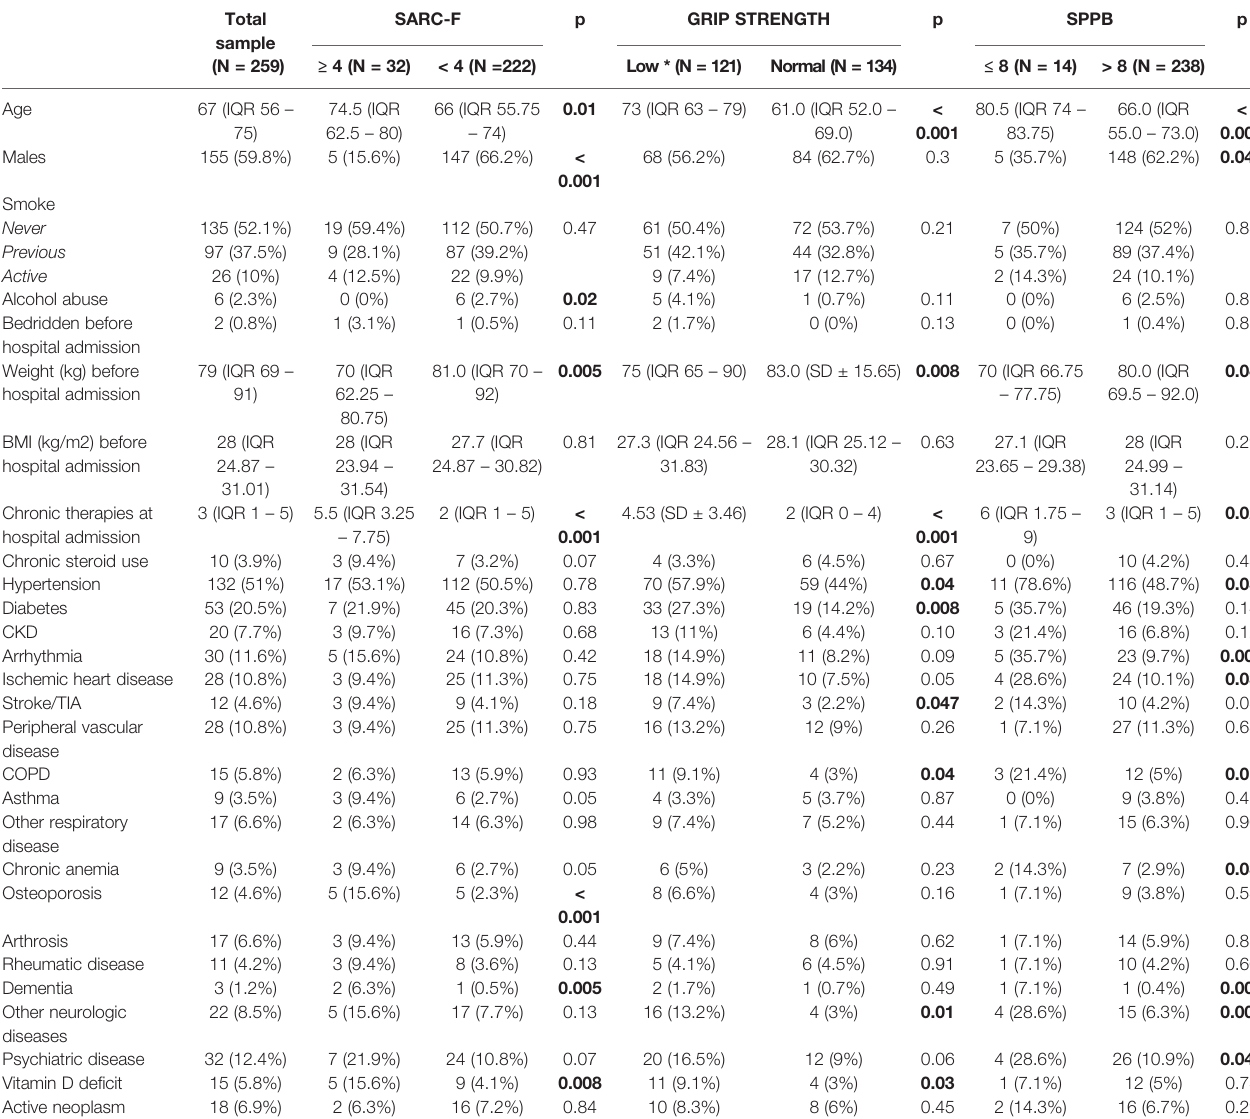
TABLE 1 | Baseline characteristics of the study population and their comparison among groups with pathologic and normal values of a sarcopenia screening tool, muscle strength and performance. Total SARC-F sample